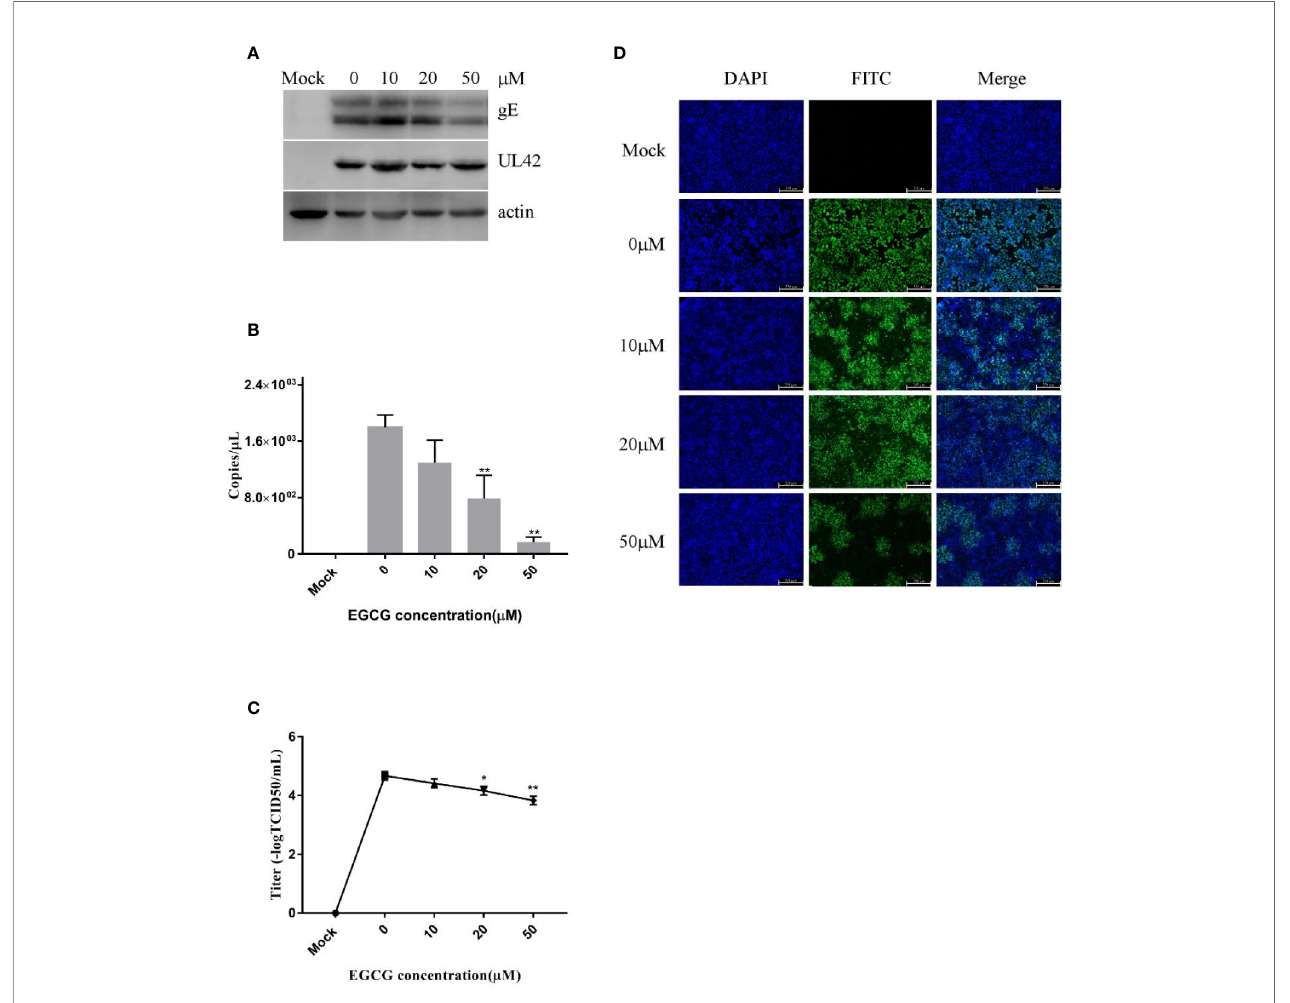
FIGURE 5 | ( – )-Epigallocatechin-3-gallate (EGCG) prevented pseudorabies virus (PRV) entry to PK15 B6 cells. PK15 B6 cells were infected with PRV XJ5 (MOI=0.1) at 4°C for 1 h, then infected cells were treated with 10, 20, or 50 m M EGCG for 1 h, before removal of the EGCG medium and culture in EGCG-free DMEM. (A) At